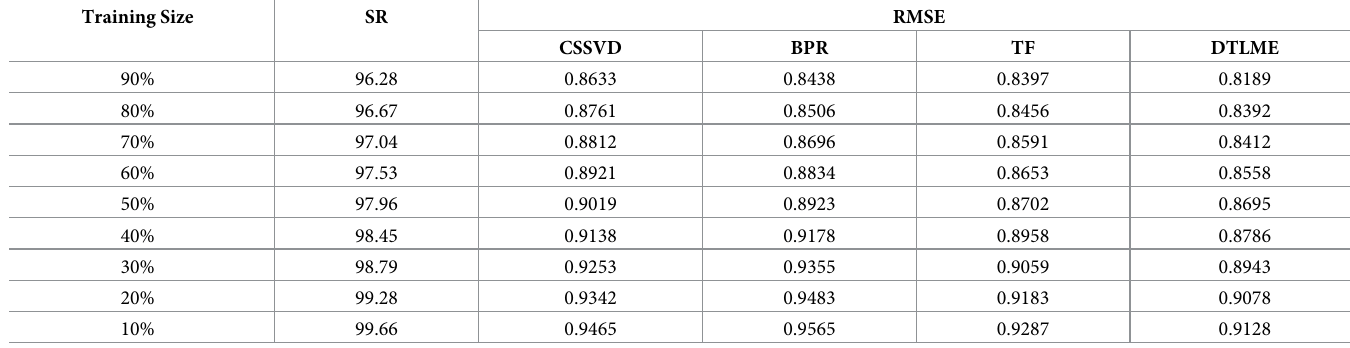
Table 4. Comparison of the proposed model with baseline algorithms for RMSE on the basis of SR.